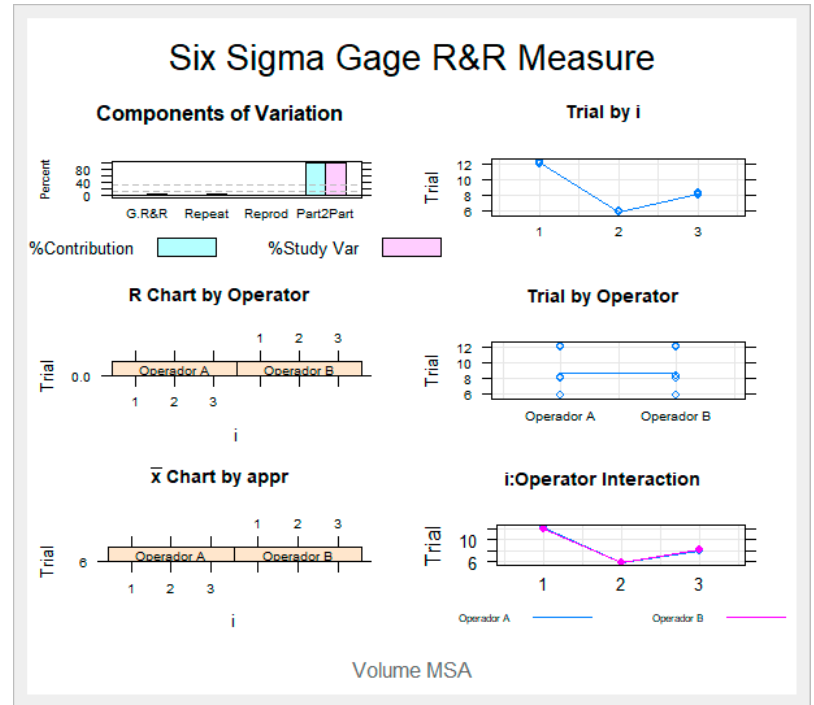
Figure 11. Measurement system analysis related to the area measurement with a chart of the contribution of each component to the total variance (Components of Variation), the mean control chart and the range control chart (R Chart by Operator and x Chart by appr), every measurement point in the graph (Trial by I and Trial by Operator), and interactions between the operators (i): Operator interaction). The means and SD values for the volume of the cement remaining after lingual multibracket therapy debonding, the area of the cement remaining after cement clearance, and the area of the enamel removed after cement clearance are displayed in Table 2. Table 2. Descriptive statistics of the volume of the cement remaining after lingual multibracket therapy debonding, the volume of the cement remaining after cement clearance, and the volume of the enamel removed after cement clearance. Operator